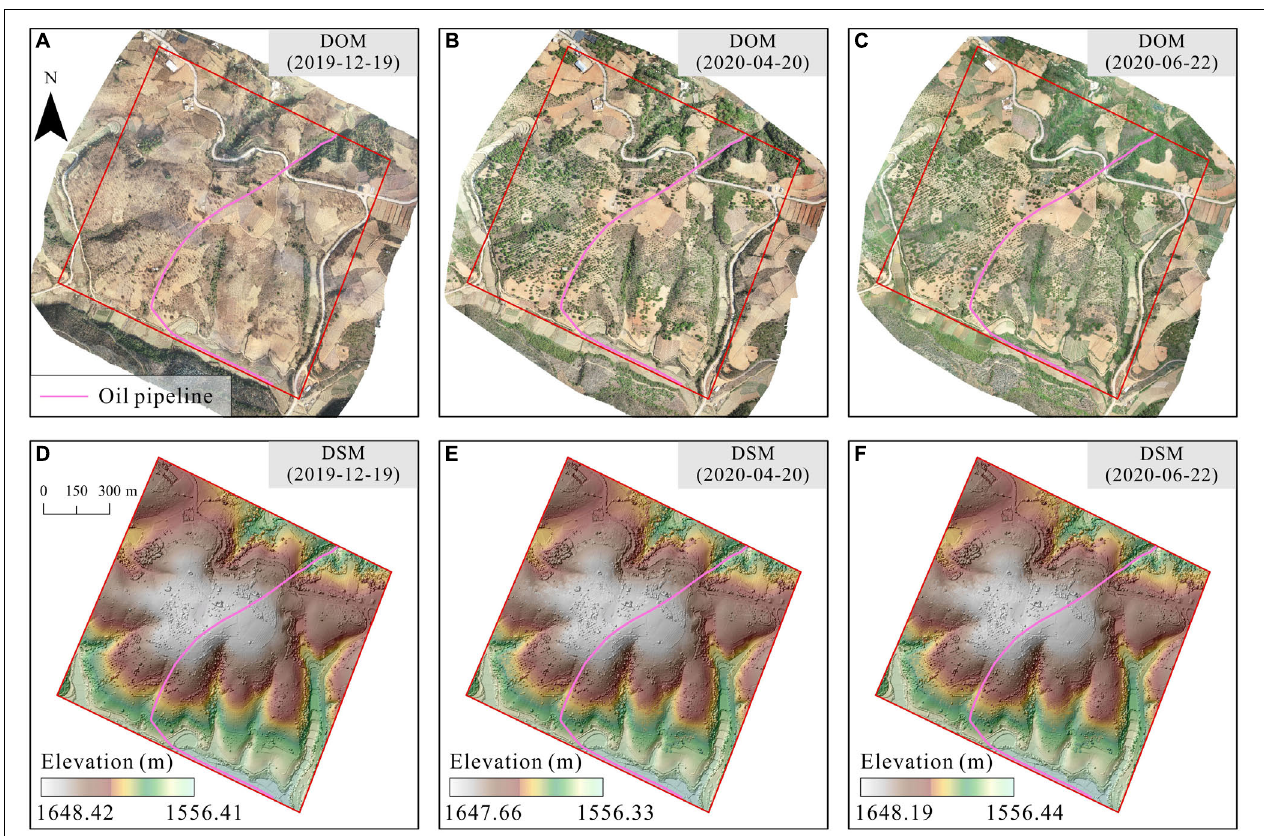
FIGURE 7 | Preliminary products of UAV photogrammetry. (A–C) Digital Orthophoto Maps (DOMs) of UAV in December 2019, April 2020, June 2020 and (D–F) Digital Surface Models (DSMs) of UAV in December 2019, April 2020, June